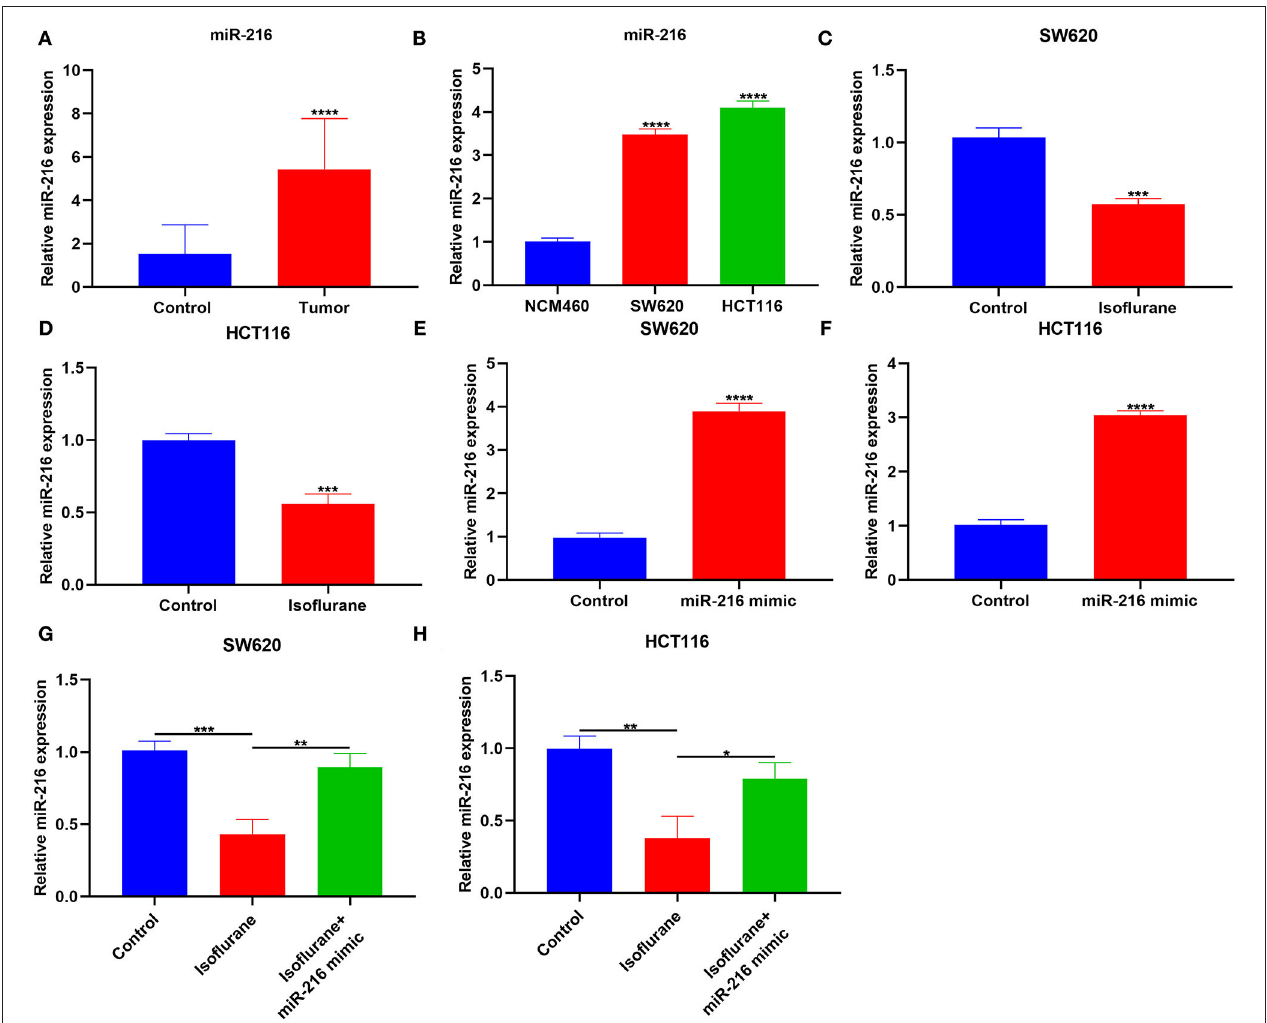
FIGURE 4 | The inhibitory function of isoflurane on miR-216 expression in CRC cells. (A) RT-qPCR for miR-216 expression in CRC and control tissue specimens. (B) miR-216 expression in NCM460, SW620, and HCT116 cells. (C,D) MiR-216 expression in (B) SW620 and (C) HCT116 cells exposed to 40 µ M isoflurane. MiR-216 expression in (E) SW620 and (F) HCT116 cells transfected by miR-216 mimic. MiR-216 expression in (G) SW620 and (H) HCT116 cells following treatment with 40 µ M isoflurane and/or miR-216 mimic. * p < 0.05; ** p < 0.01; *** p < 0.001; **** p < 0.0001.